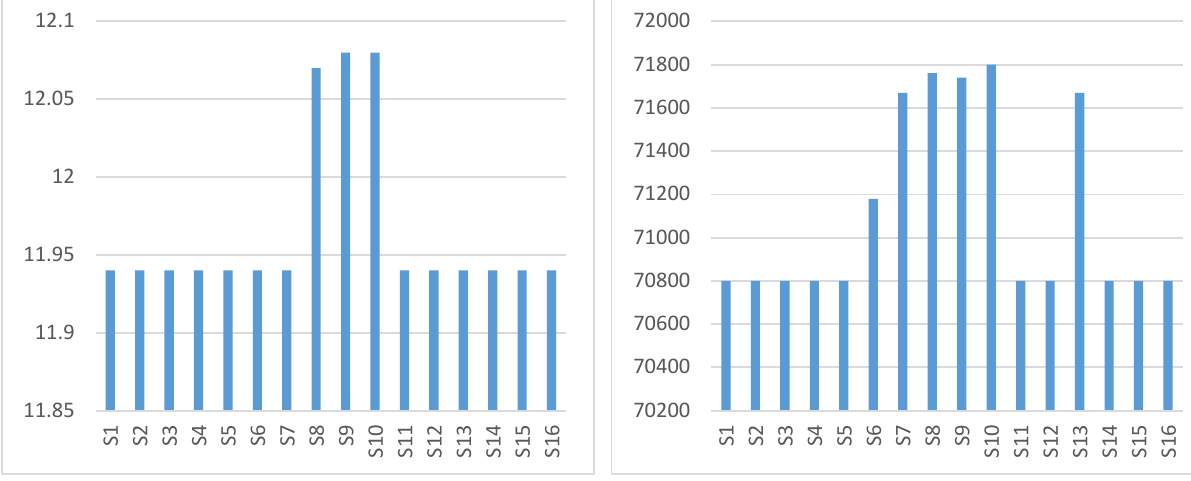
Fig. 3. The failure rate Fig. 4. The delivery